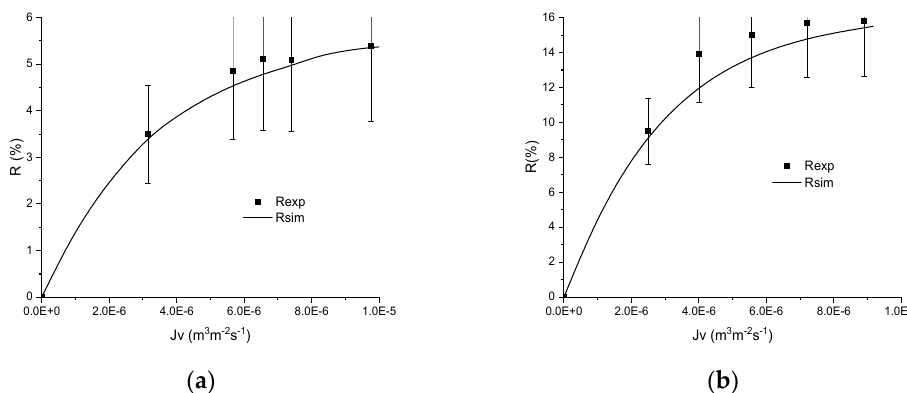
Figure 6. Rejection curves obtained experimentally and simulated from the corresponding best-fitted Langmuir–Freundlich isotherms obtained by filtration by the MFI–MFI membrane of NaF ( a ) 50 mol m − 3 and ( b ) 2 mol m − 3 .